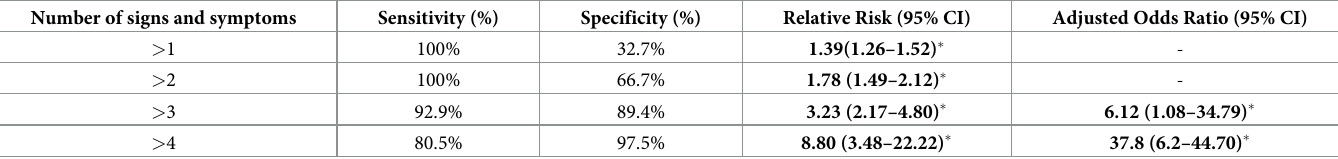
Table 4. Sensitivity and Specificity of the Number of Signs and Symptoms.